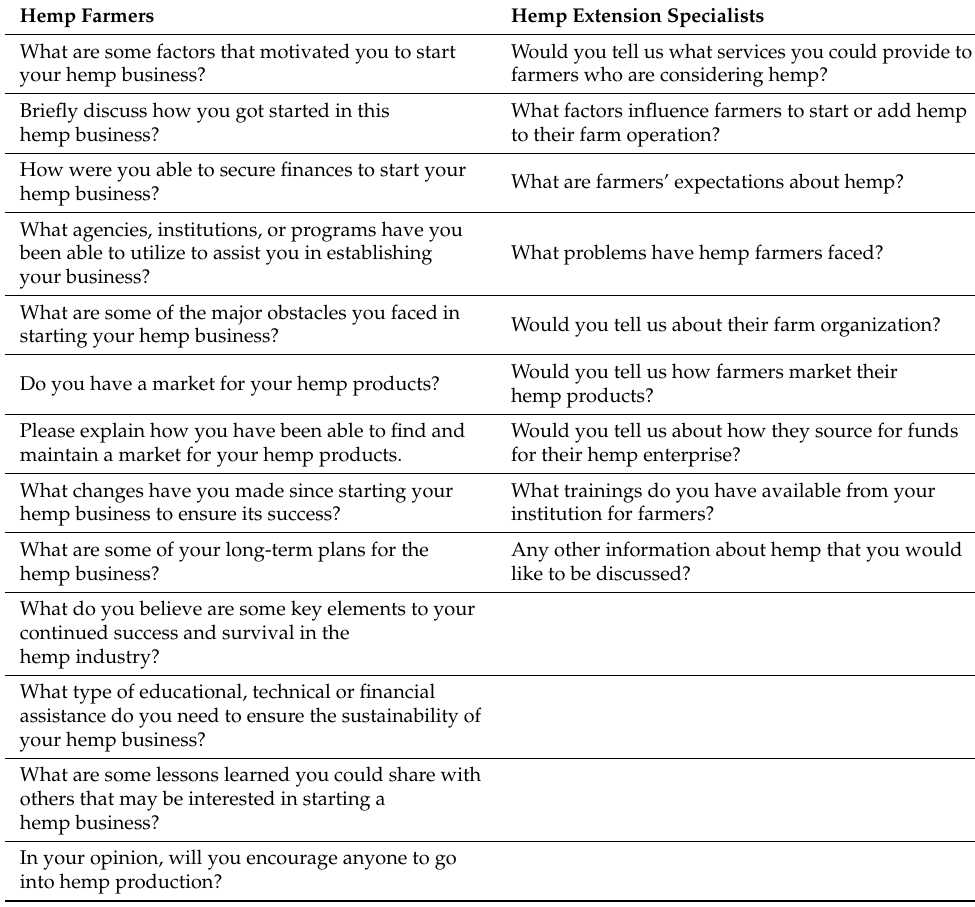
Table 1. Key Focus Group Discussion and Interview